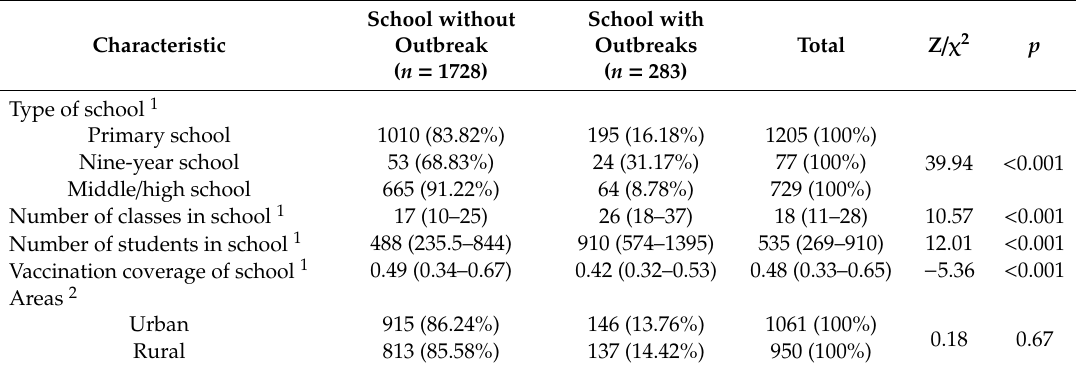
Table 3. Characteristic of schools in Beijing, from August 2018 to July